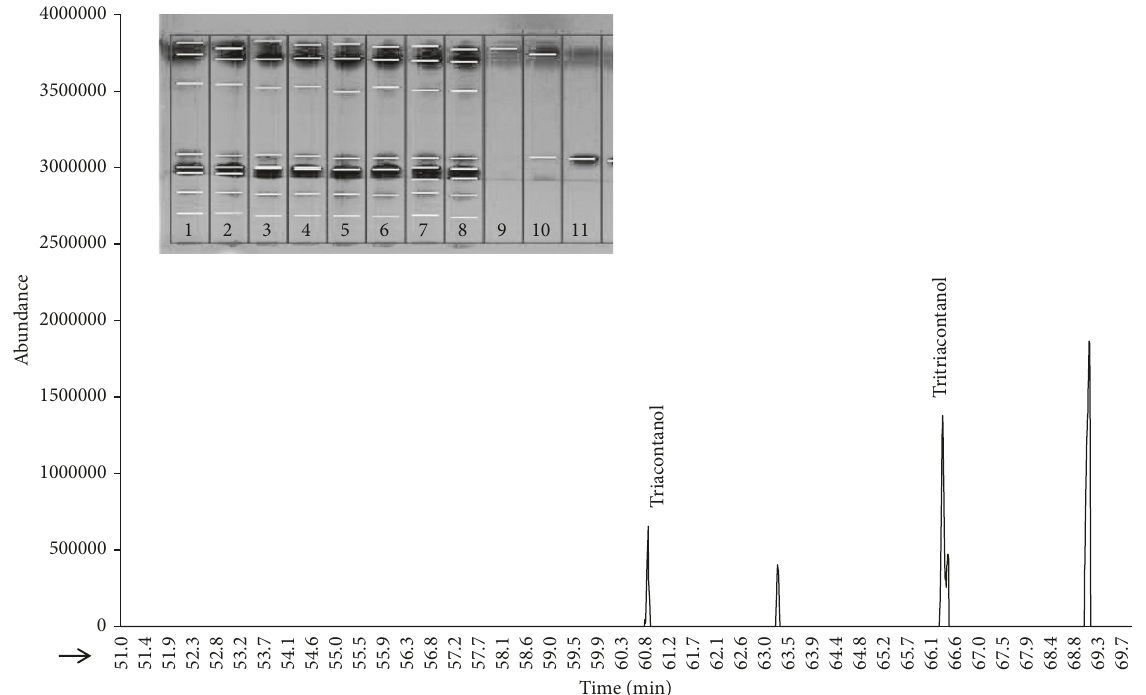
Figure 3: Policosanol composition in toluene medium, using propanol as the acyl receptor, in the enzymatic transesterification under sonication. HPTLC chromatoplate shows products of the reaction over time from lanes 1 to 8; lane 9 is the reaction target without enzyme; lane10 is the purified wax; and lane 11 is the triacontanol standard (30C).